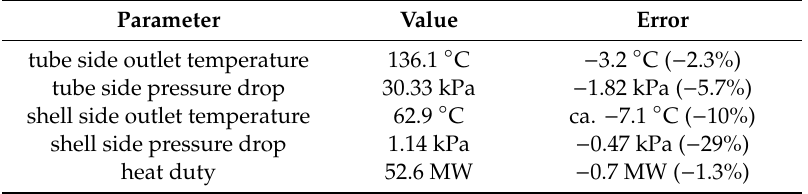
Table 6. Results obtained using the present model and the corresponding errors compared to the data from the operator of the boiler. The accuracy was not as good as in the case of HTRI Xchanger Suite, but, in terms of fast, approximate analyses of process and power equipment, it was su ffi cient.